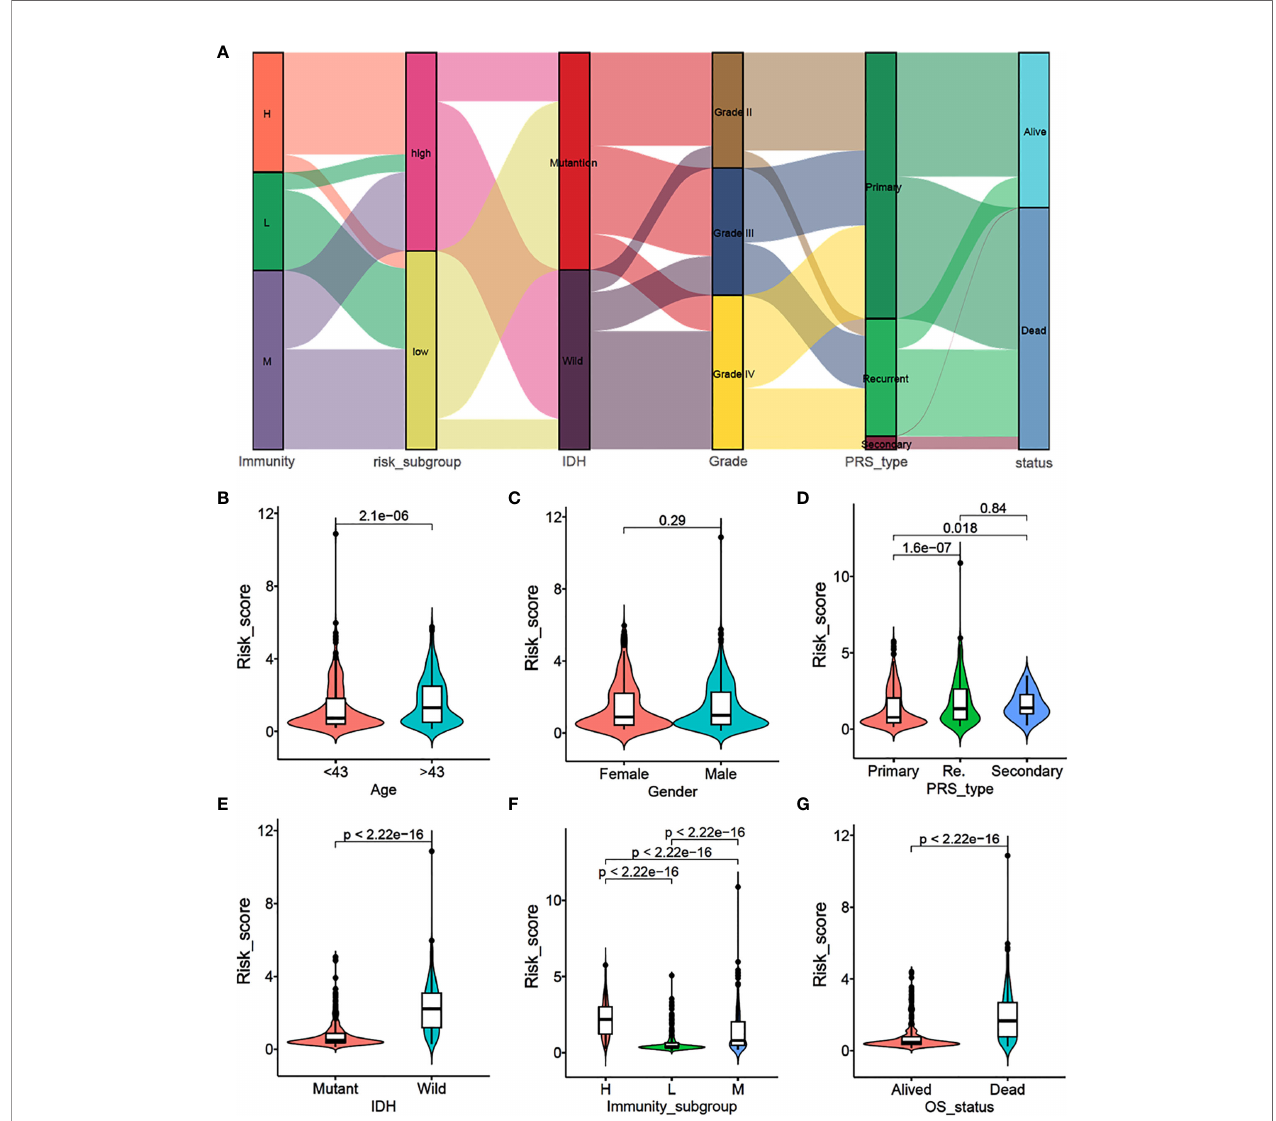
FIGURE 2 | Association analysis and risk score comparison of clinical features of glioma. (A) Alluvial diagram of immunity-sub-groups with different risk-subgroups, IDH status, grade stages, PRS types and survival status. (B – G) The risk score comparison between different clinical features. (B) Age, (C) Gender, (D) PRS type, (E) IDH status, (F) immunity-subgroup and (G) survival